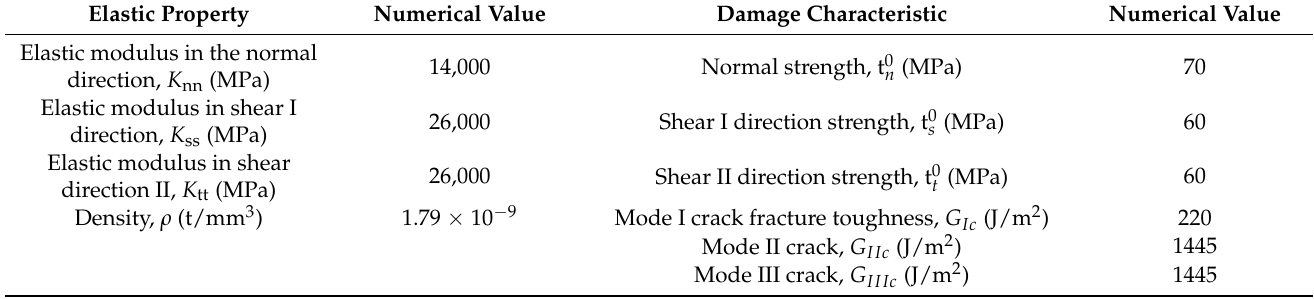
Table 3. Mechanical properties of CFRP interlamination at room temperature.